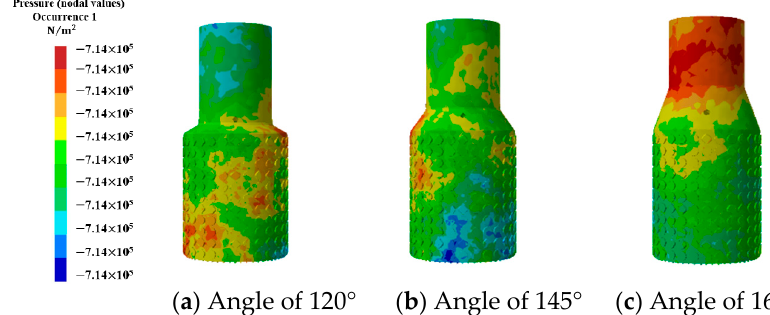
Figure 8. First-order acoustic cavity modality.